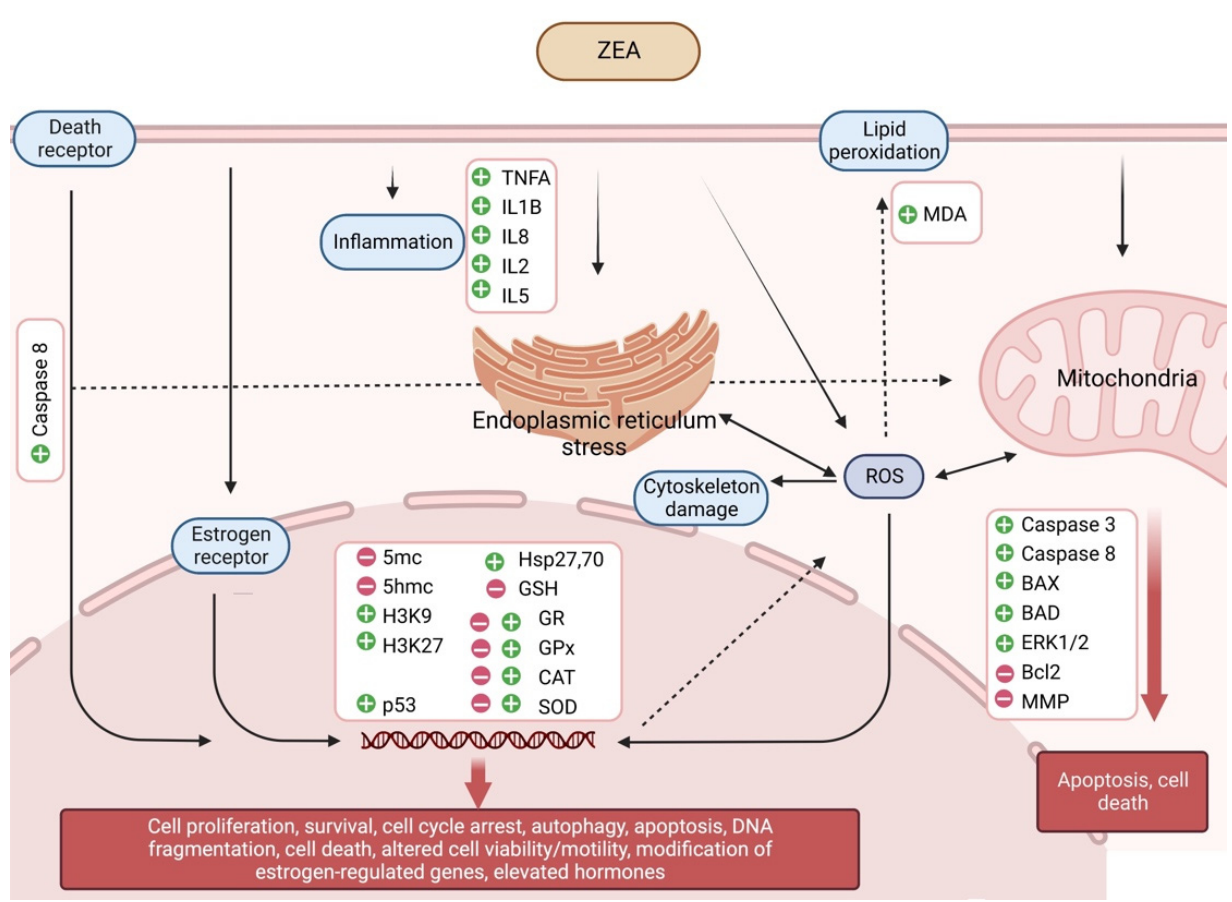
Figure 3. Estrogenic and non-estrogenic effects of zearalenone.